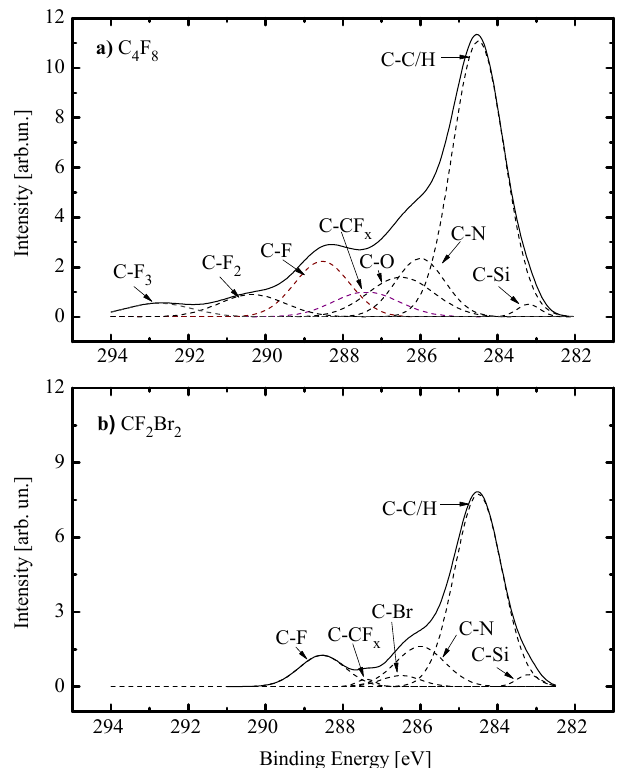
Figure 4. XPS spectra for C 1s on the plasma-treated SiO x N y surface after pure C 4 F 8 ( a ) and CF 2 Br 2 ( b ) gases. Plasma parameters correspond to Figure 1.